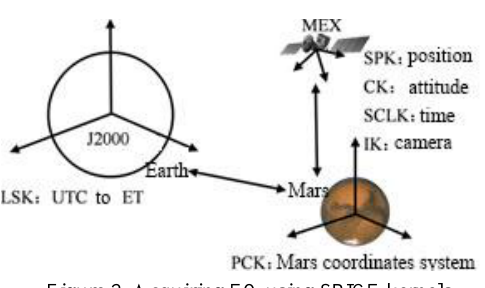
Figure 2. Acquiring EO using SPICE kernels